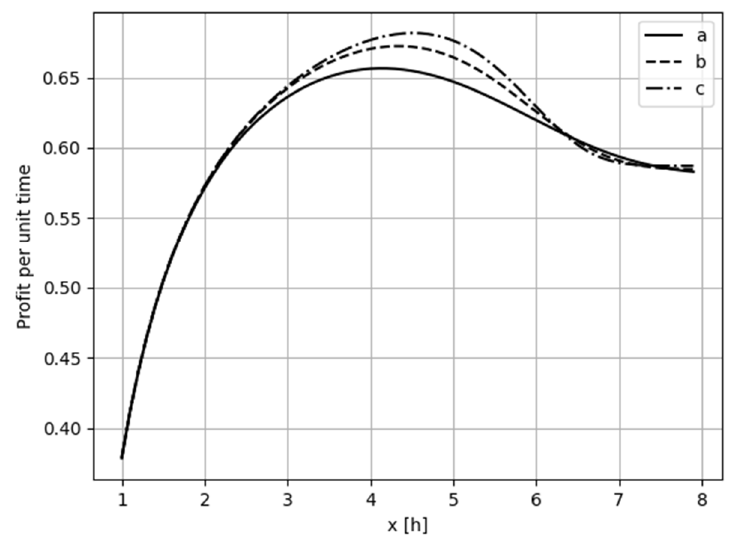
Figure 2. Graphs of the function g(x)—profit per time unit as a function of time to preventive replacement, x [h], determined for a Weibull distribution with parameter values scale = 6 and shape = 5 (curve a), shape = 7 (curve b), shape = 9 (curve c).